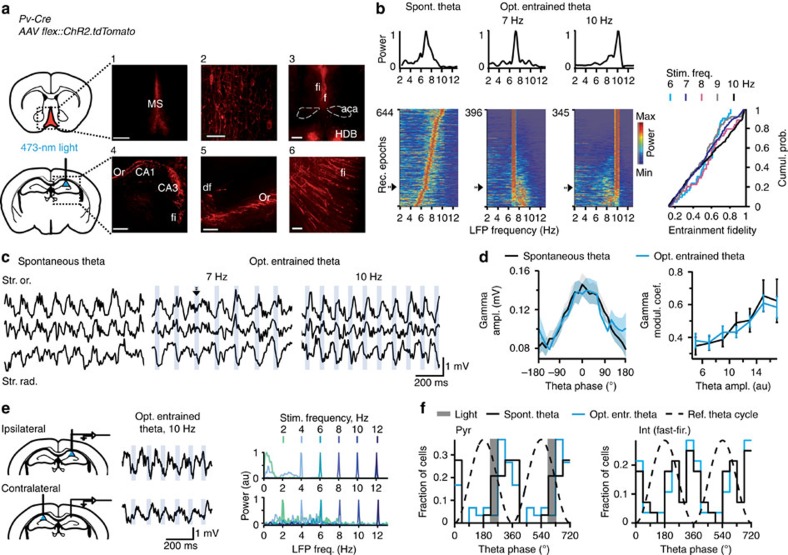
Optogenetic control of hippocampal theta oscillations.(a) Injections of Cre-dependent ChR2 in MS of PV-Cre mice and light-induced stimulation of MS–Hip projections. Expression of AAV2/1.CAGGS.flex.ChR2.tdTomato.WPRESV40: neuronal somata in MS (1,2), fibre tracts, fimbria (fi)-fornix (f), nucleus of the horizontal limb of the diagonal band (HDB) (3,5,6) and axons in the Hip (4,5). Scale bars, 500 μm (1,3,4) and 50 μm (2,5,6). (b) Left: LFP PSD (colour coded, computed for 10-s epochs) for all control recordings, as well as optostimulation at 7 and 10 Hz (N=9 mice). Power spectra marked with arrows are shown on top. The rows are ordered according to entrainment fidelity (optogenetically entrained theta), or dominant theta frequency (spontaneous theta). Right: cumulative distribution of theta entrainment fidelity for various optostimulation frequencies. (c) Laminar LFP profiles of spontaneous and optogenetically controlled theta oscillations; str. or., stratum oriens; str.rad., stratum radiatum. It is worth noting that the light pulse marked by an arrowhead (at 7 Hz) resets theta phase, thus adjusting the rhythm frequency to the stimulation frequency. (d) Phase–amplitude coupling of theta and gamma oscillations (left) compared across theta amplitudes (right) between spontaneous and optogenetically entrained theta (P=0.42, N=3 mice, 8 and 19 recordings, respectively). Data are presented as mean±s.e.m. (e) Intact bilateral coordination of optogenetically entrained theta oscillations (P<0.05, Pearson's correlation, N=5 mice). Left: signal traces recorded during ipsi- (top) and contralateral (bottom) hippocampal stimulation; right: respective LFP power spectra during optostimulation. (f) Left: histograms of preferred discharge phases of CA1 pyramidal cells (opt. entrainment: blue, 30 neurons; spontaneous theta: black, 29 neurons). Grey shaded bar: a theta phase bin when timestamps of laser pulse were preferentially recorded. Right: histograms of preferred discharge phases of fast firing interneurons (n=28 neurons). Preferred theta phases did not differ (pyramidal cells, P=0.79, Watson–Williams test; fast firing interneurons, P=0.97, Watson U2 permutation test).